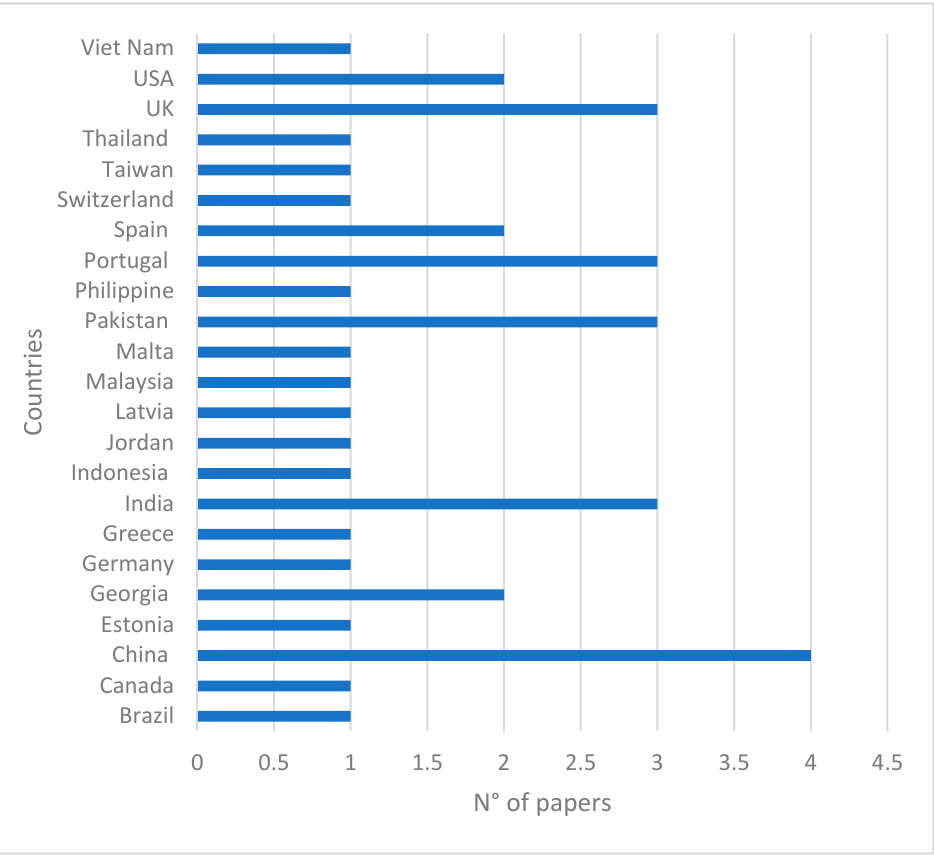
Figure 2. Publications distribution per years.